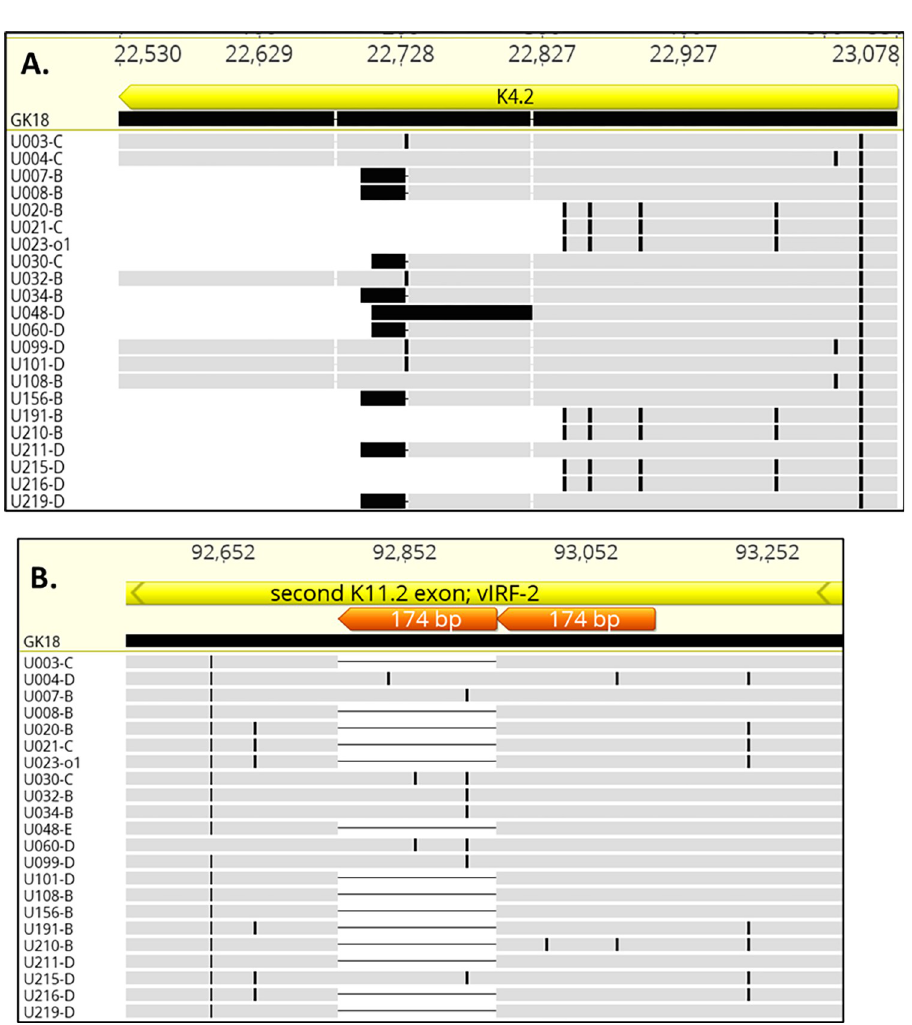
Fig 6. Polymorphisms in K4.2 and K11.2. Alignment of predicted K4.2 (A.) and K11.2 (B.) amino acid sequences in whole KSHV genomes sequenced in this study aligned against the GK18 reference, showing 3 length genotypes. Black marks indicate amino acid differences from GK18. The 22 sequences in (A) are representative of K4.2 length polymorphisms found in the 98 KSHV genomes sequenced to date. The 174-bp repeats found in K11.2 are in orange.